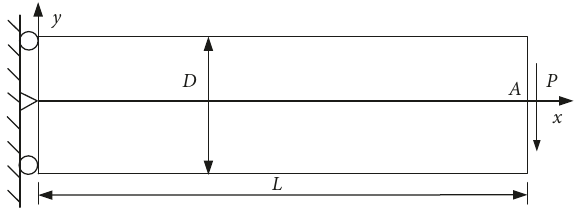
Figure 4: Cantilever beam